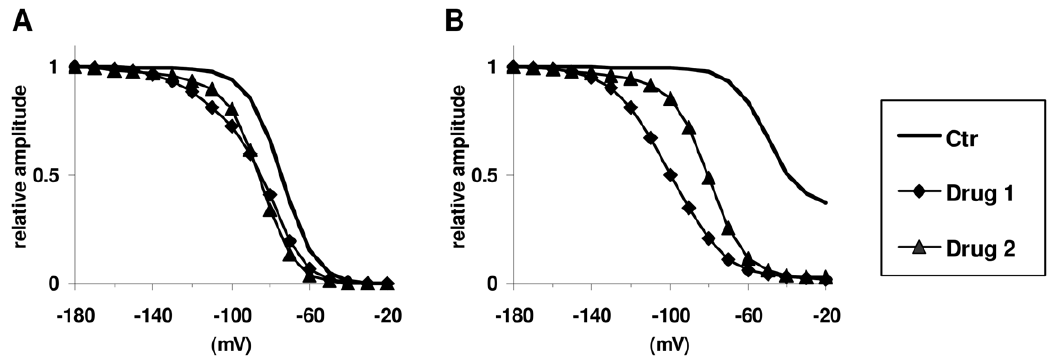
Figure 1. Effectiveness of two simulated drugs in ‘‘steady-state fast inactivation’’ and ‘‘steady-state slow inactivation’’ protocols. A typical example showing that state preference of drugs cannot reliably be deduced from these protocols (see Figure 2). Drug 1 has preferential affinity to fast inactivated state, while Drug 2 prefers slow inactivated state. A , ‘‘steady-state fast inactivation’’ protocol. B , ‘‘steady-state slow inactivation’’ protocol.